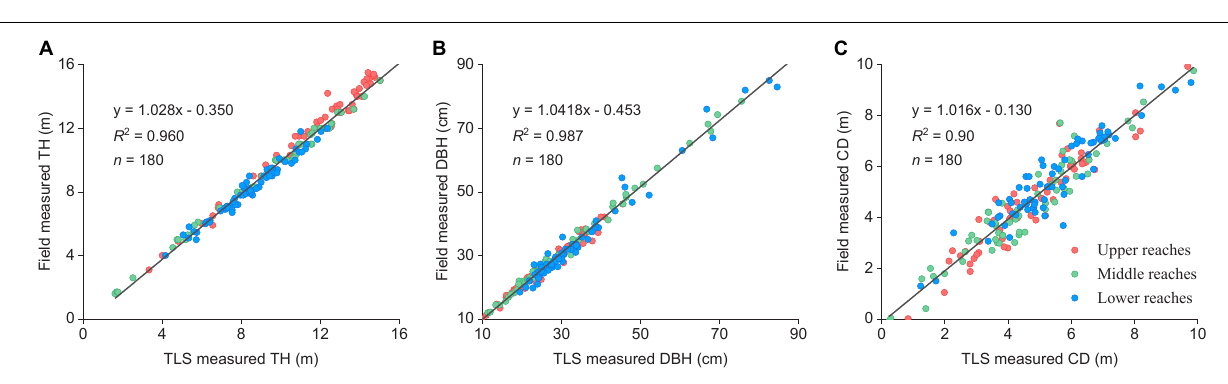
FIGURE 3 | (A) Linear statistical regression analysis of TH results. (B) Linear statistical regression analysis of DBH results. (C) Linear statistical regression analysis of CD results between TLS and field data. Blue, red, and green points indicate the values acquired from the upper, middle, and lower reaches.